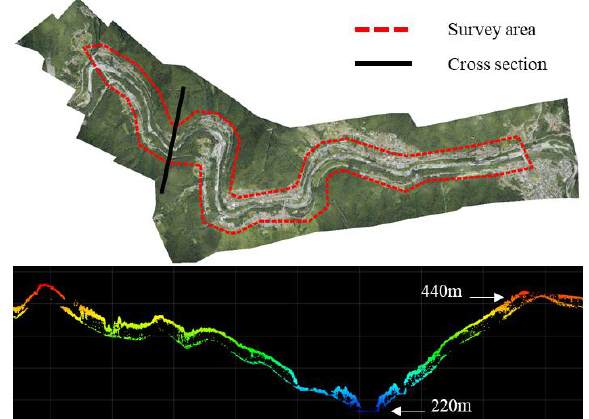
Figure 2. Target area of the preliminary experiment